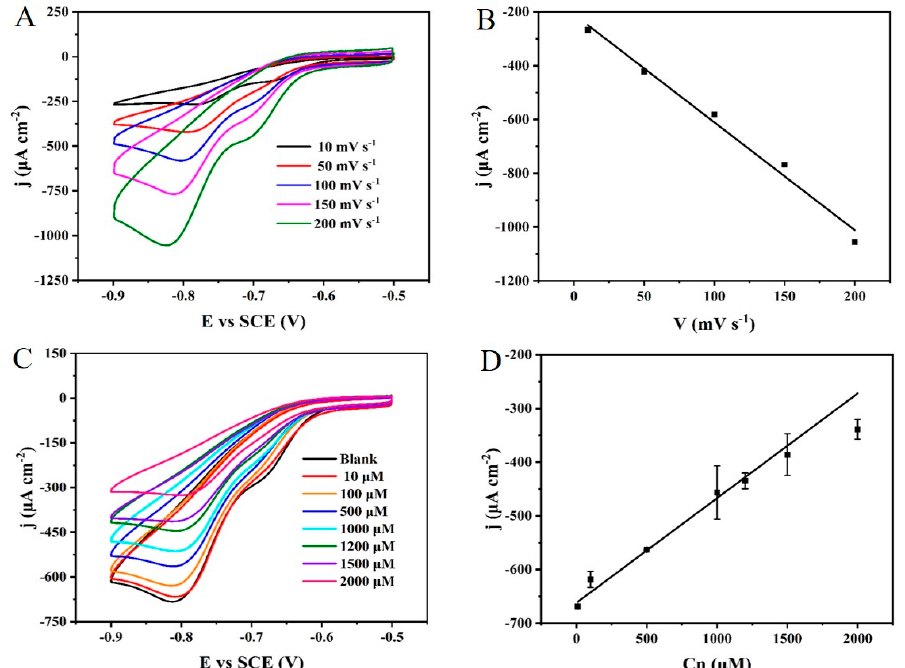
Figure 5. ( A ) The CV curves of the NPG/GCE in NaOH (0.2 M) containing 4.0 mM picric acid at different scan rates. ( B ) The linear relationship between the reduction peak current density of picric acid and the scan rate. ( C ) The CV curves of the NPG/GCE in NaOH (0.2 M) containing 4 mM picric acid and different concentrations of creatinine ( D ) The linear relationship between the reduction peak current density of picric acid and creatinine concentration.